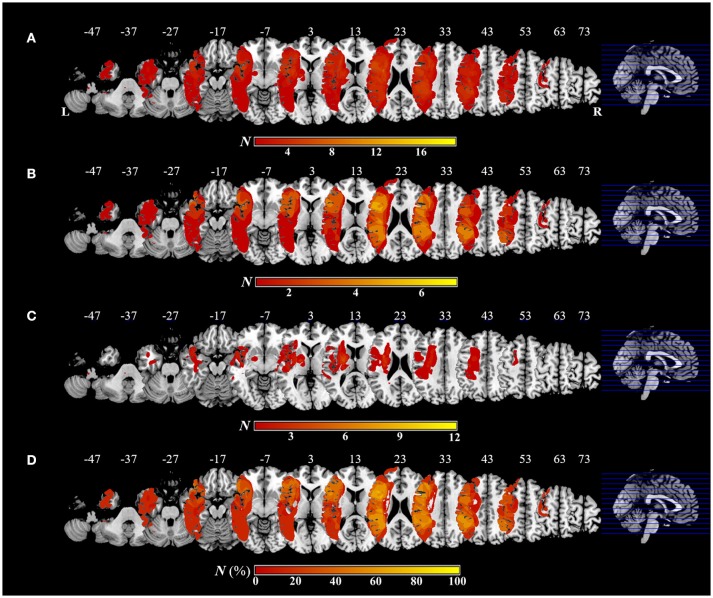
Overlap and distribution of ischemic lesions of all patients and each group, and subtraction lesion mapping. The number of overlapping lesions is illustrated by different colors indicating increasing frequency from red to yellow. Montreal Neurological Institute z coordinates of each transverse section are given. L, left hemisphere; R, right hemisphere; N, number of individuals with a lesion in a given voxel; N (%), number of lesion overlaps after subtraction, expressed as a percentage. (A) Overlap and distribution of ischemic lesions of all patients (n = 19). (B) Overlap and distribution of ischemic lesions of the apraxic group (n = 7). (C) Overlap and distribution of ischemic lesions of the pseudo-apraxic and unaffected groups (n = 12). (D) After subtraction of lesion overlap of the patients in the pseudo-apraxic and unaffected groups from the lesion overlap of the patients in the apraxic group, lesioned voxels in the left precentral gyrus, left inferior frontal gyrus (including the opercular triangular regions), left rolandic operculum, left insular, and left inferior parietal lobule (including the left supramarginal gyrus) were associated with apraxia after stroke.